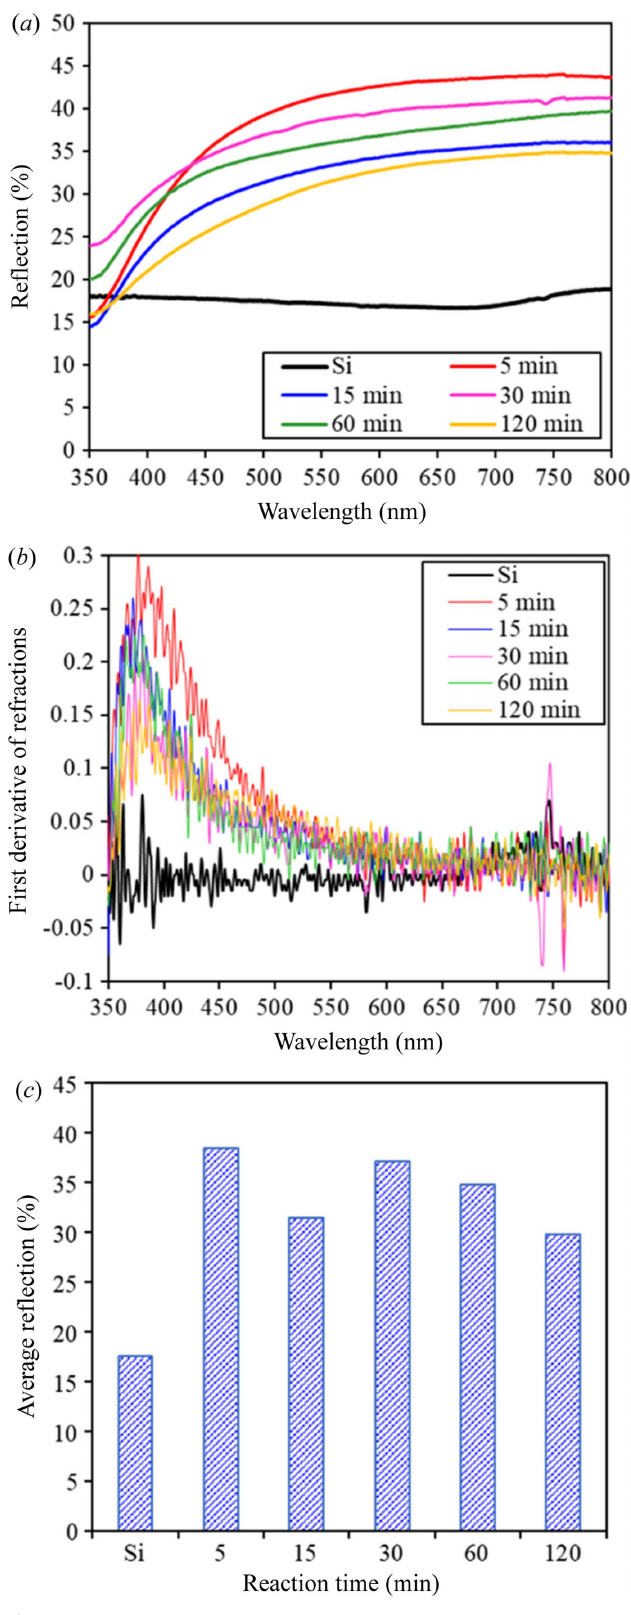
Figure 5 Si substrate and Ag-DNF/Si samples with various synthesis times: ( a ) reflection spectra, ( b ) first-derivative spectrum and ( c ) average reflection in spectra (350–800